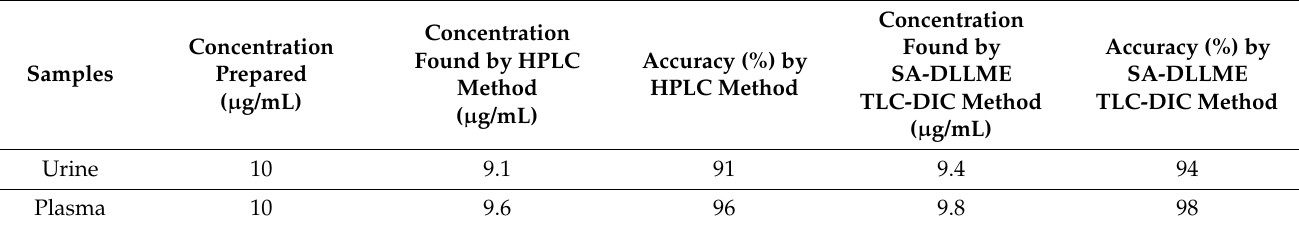
Table 6. Determination of FAV in spiked biological samples ( n = 5).